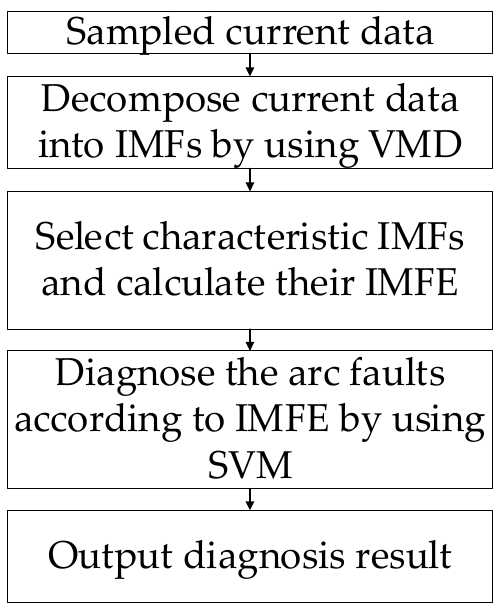
Figure 1. Block diagram of the proposed diagram.